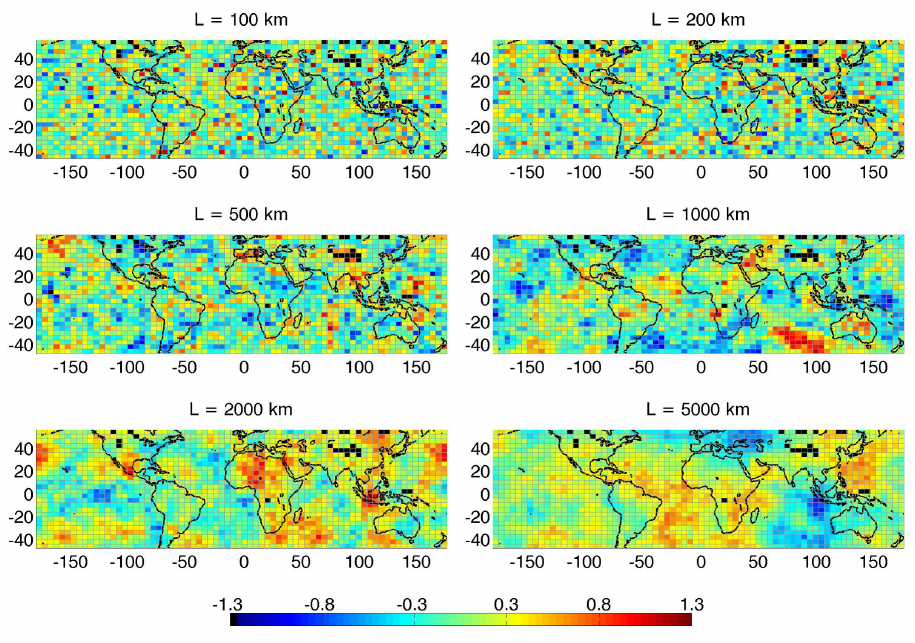
Fig. 3. Spatial images of randomly selected realizations of the synthetic MOPITT CO column observation errors ˜ (cid:15) (in units of 10 18 moleculesCOcm − 2 ) for December 2000 for different values of L . The black cells represent missing observations.